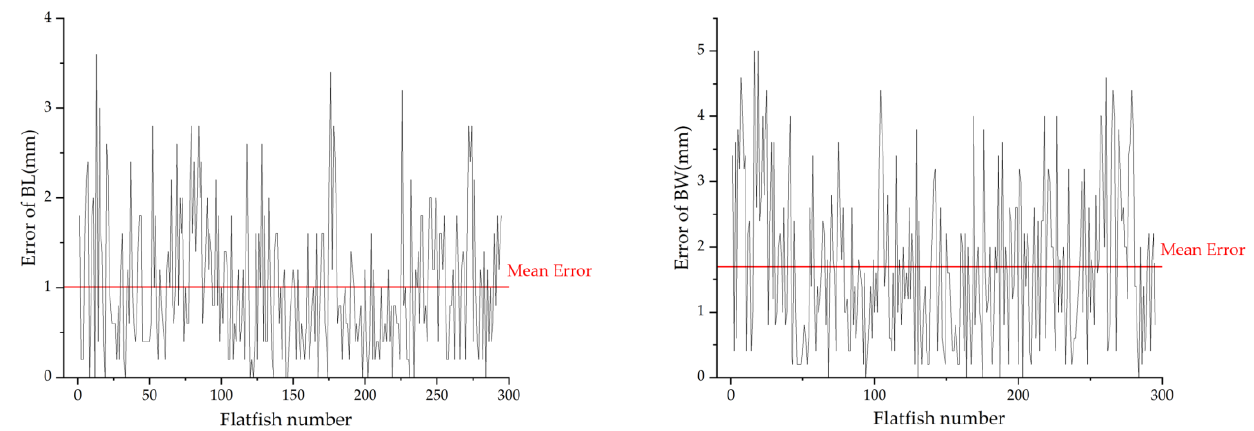
Figure 8. Absolute error of BL and BW.